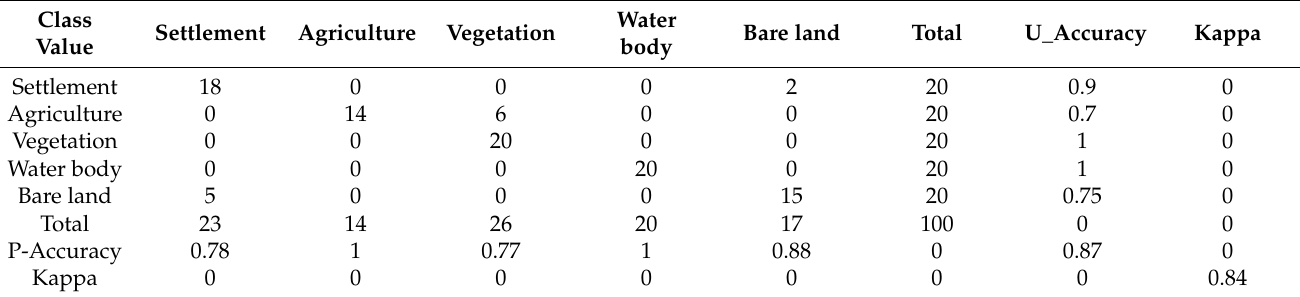
Table 2. Supervised classified land use confusion